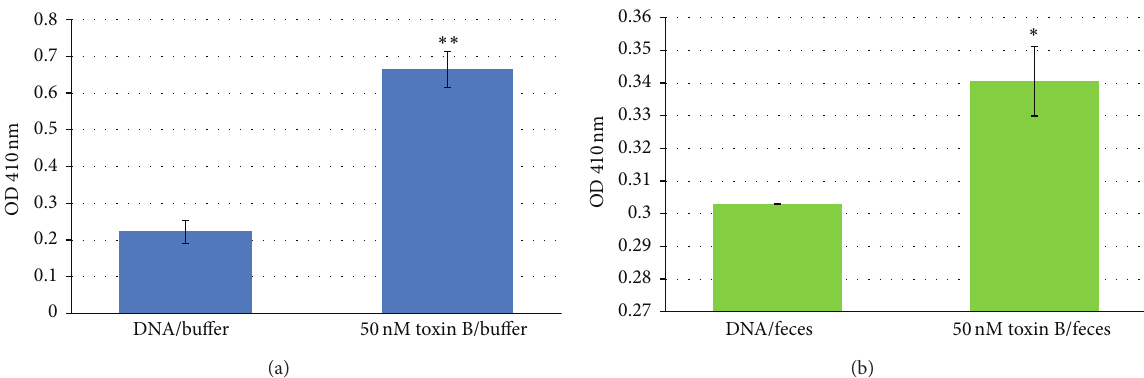
Figure 7: Modified ELISA assays of toxin B. Data from one modified sandwich ELISA assay with absorbance measured at OD 410nm. Absorbance levels presented are subtracted from background levels of blank wells without immobilized DNA (negative control). Error bars represent 2x standard deviations of 2 sample replicates. (a) Statistical significance levels with respect to DNA in buffer background (without toxin B) of 𝑃 < 0.01 are designated by ∗∗ . (b) Statistical significance levels with respect to fecal background (without toxin B) of 𝑃 < 0.05 are designated by ∗ . Buffer: 1x selection buffer; feces: 1g/20 mL 1x selection